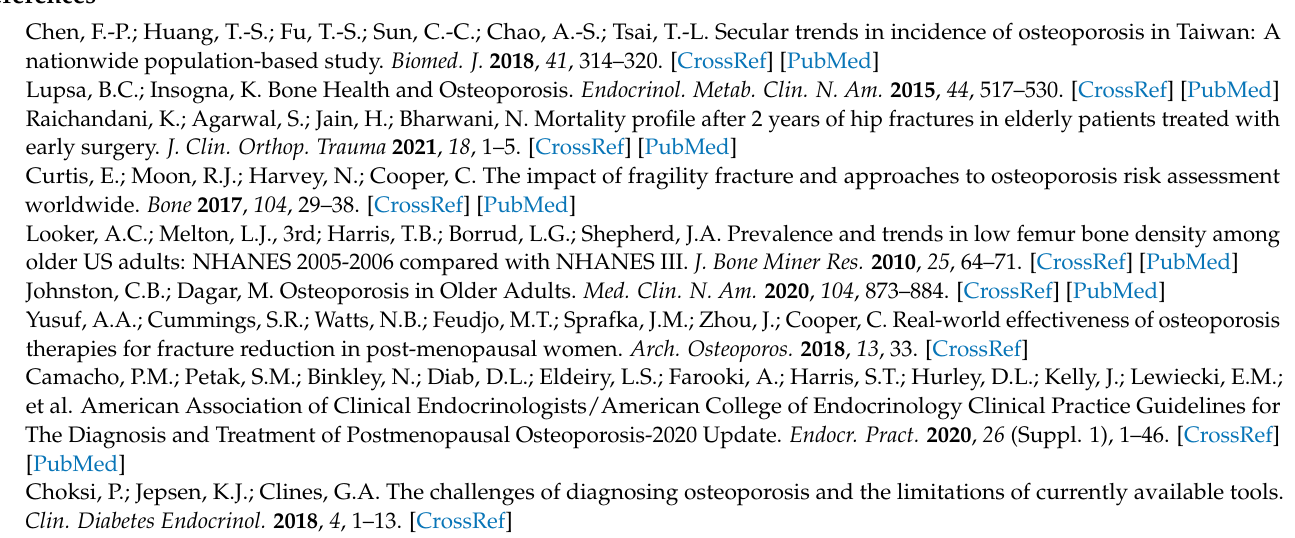
Table S2: Performance of the full models and the smaller models with 6 variables for prediction of osteoporosis in men and